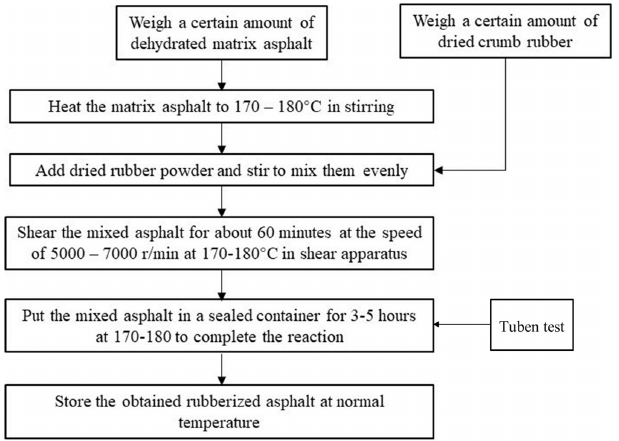
Figure 1. Preparation flow chart of rubberized asphalt.